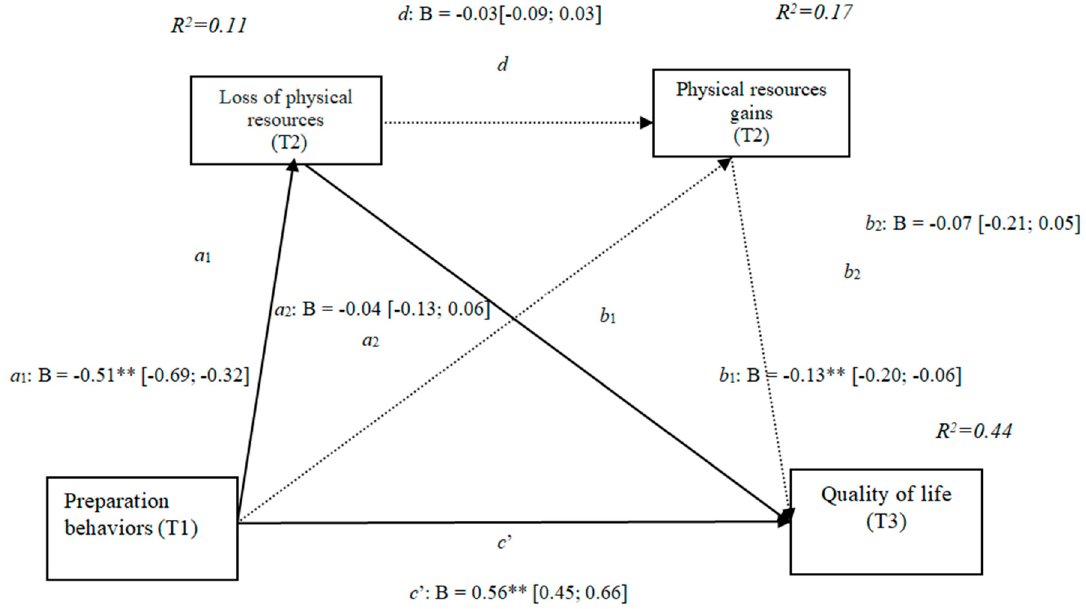
Figure 2. Non-standardized B coefficients, confidence intervals, and statistical significance for physical losses and gains. [95% CI]; * p < 0.05; ** p < 0.01.